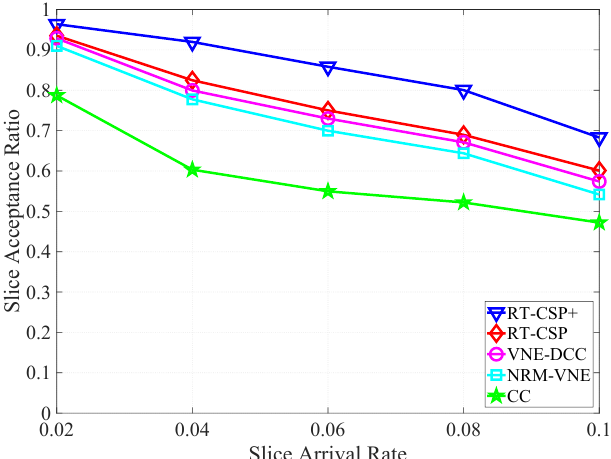
Figure 6. Slice acceptance ratio in the different arrival rates scenario.